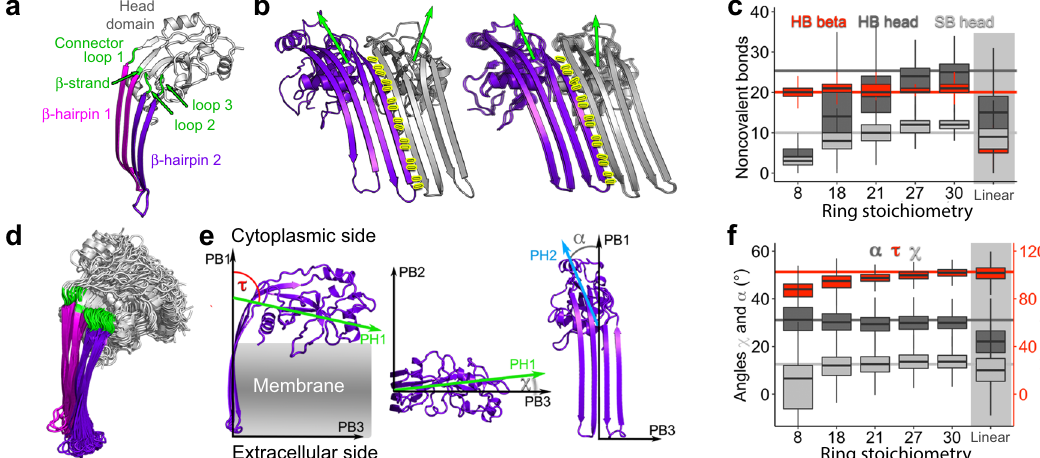
Fig. 6 mGSDMA3 Nterm head domain rotates to stabilize ring-shaped oligomers of different stoichiometries. a Membrane-inserted mGSDMA3 Nterm structure taken from Fig. 5d. Transmembrane β -hairpins are colored magenta and purple, hydrophilic head domain light gray, and ‘ elastic head-to-hairpin connector ’ green. b Hydrogen bond network (yellow sticks) between β -hairpins of neighboring mGSDMA3 Nterm (colored purple and gray) in membrane- inserted ring-shaped oligomers formed by 18 (left) and 30 (right) mGSDMA3 Nterm . Green arrows highlight orientations of head domains. c Number of noncovalent interactions formed by each mGSDMA3 Nterm within membrane-inserted ring-shaped oligomers having different stoichiometries. HB beta gives hydrogen bonds between β -hairpins of neighboring mGSDMA3 Nterm . HB head gives hydrogen bonds and SB head salt bridges between hydrophilic head domains. The data contains two simulations per oligomeric stoichiometry with n > 9000 time values taken every 100 ps for the whole simulation length after exclusion of the fi rst 100 ns for equilibration purposes (Supplementary Table 2). d Flexibility of connector and head domain of membrane- inserted mGSDMA3 Nterm . Overlay of mGSDMA3 Nterm from ring-shaped oligomers having 8, 18 and 30 stoichiometries, each simulated for 1 µ s. e Angles describing the head domain movement of membrane-inserted mGSDMA3 Nterm . The angle τ (red) between the principal axes PH1 and PB1 describes the vertical movement of the head domain along the membrane normal. The angle χ (light gray) between the principal axes PH1 and PB3 describes the horizontal movement of the head domain along the membrane plane. The angle α (dark gray) describes the rotation of the second principal axis of the head domain (PH2) around the fi rst principal axis of the β -sheets (PB1). f Rotation of membrane-inserted mGSDMA3 Nterm head domains in dependence of the ring-shaped oligomer stoichiometry. Angles α , τ and χ as in ( e ). Data follows that in ( c ). Horizontal lines in ( c , f ) visualize the bonds and angles of the in vacuo energy minimized cryo-TEM structure of the membrane-inserted ring-shaped oligomer assembled from 27 mGSDMA3 Nterm[21] . Boxplot visualizations follow standard R settings, i.e. bottom and top of the box are 25th (Q1) and 75th (Q3) percentile, the band near the middle of the box is the median, the whiskers extend the box size (Q3 – Q1) 1.5